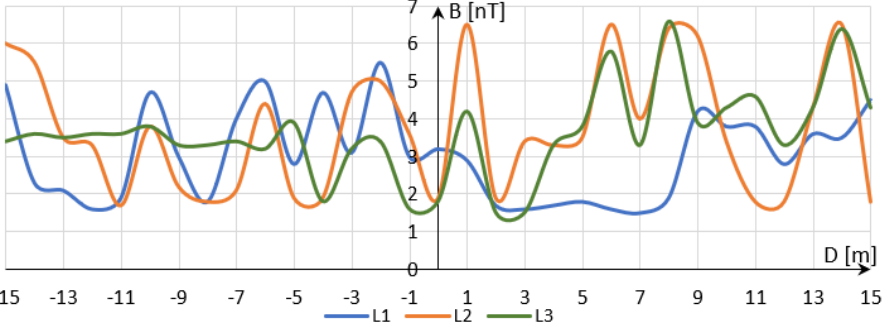
Figure 9. Distribution of magnetic field induction B along L1, L2, L3 phase conductors of the 30 kV container power line, VLF frequency range.